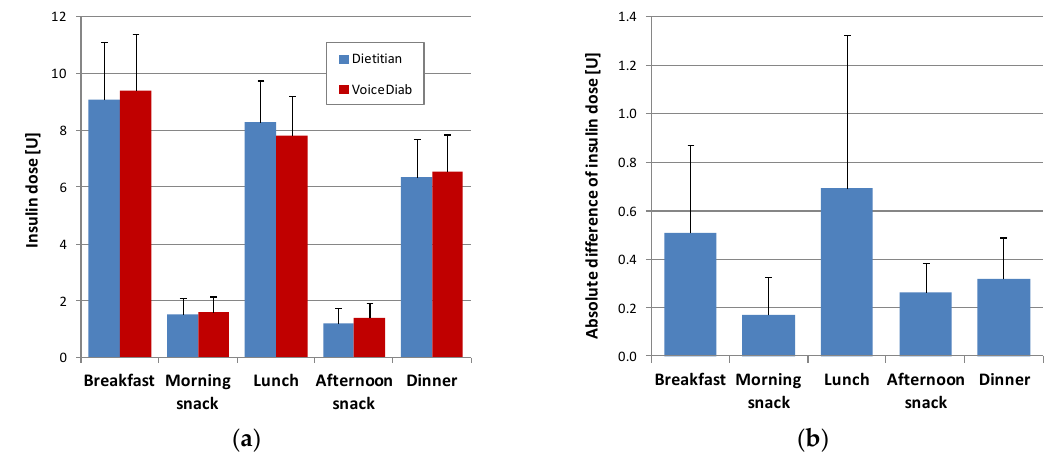
Figure 1. ( a ) Comparison of insulin doses, and ( b ) absolute differences of insulin doses calculated based on carbohydrate (CHO), protein and fat contents provided by the dietitian and the VoiceDiab system.